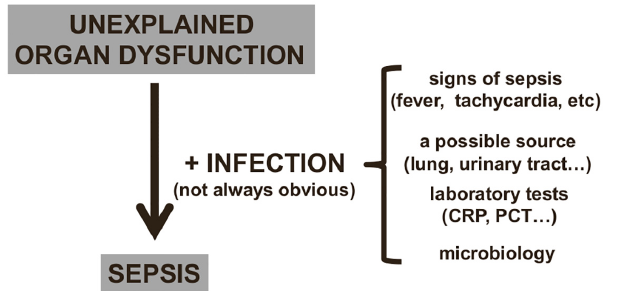
Fig 2. Diagnosing sepsis from organ dysfunction. In critically ill patients, infection can be difficult to identify (see text), and sepsis is often suspected by the presence of unexplained organ dysfunction, which should lead to a search for the underlying infection. CRP: C-reactive protein; PCT: